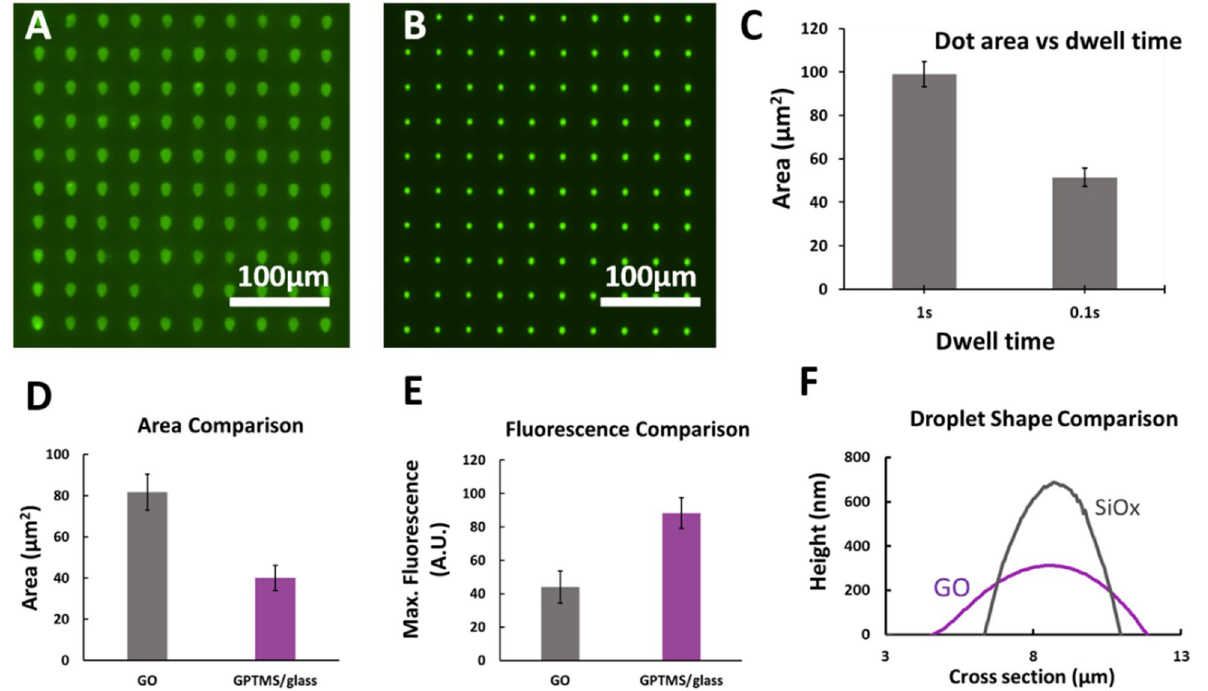
Figure 2. Comparison of protein spotting results on GO and control substrates. Fluorescent microscopy image of a typical spotting outcome on ( A ) a graphene oxide substrate and ( B ) a GPTMS/glass substrate, before removing of excess ink. ( C ) Change in droplet size on graphene oxide substrates for long and short spotting dwell time. ( D ) Comparison of droplet size for GPTMS/glass and graphene oxide substrates from 3 different prints. ( E ) Maximal fluorescence of droplets for GPTMS/glass and graphene oxide substrates from 3 different prints. ( F ) Comparison of averaged AFM profile lines of droplets on a SiO x surface and graphene oxide